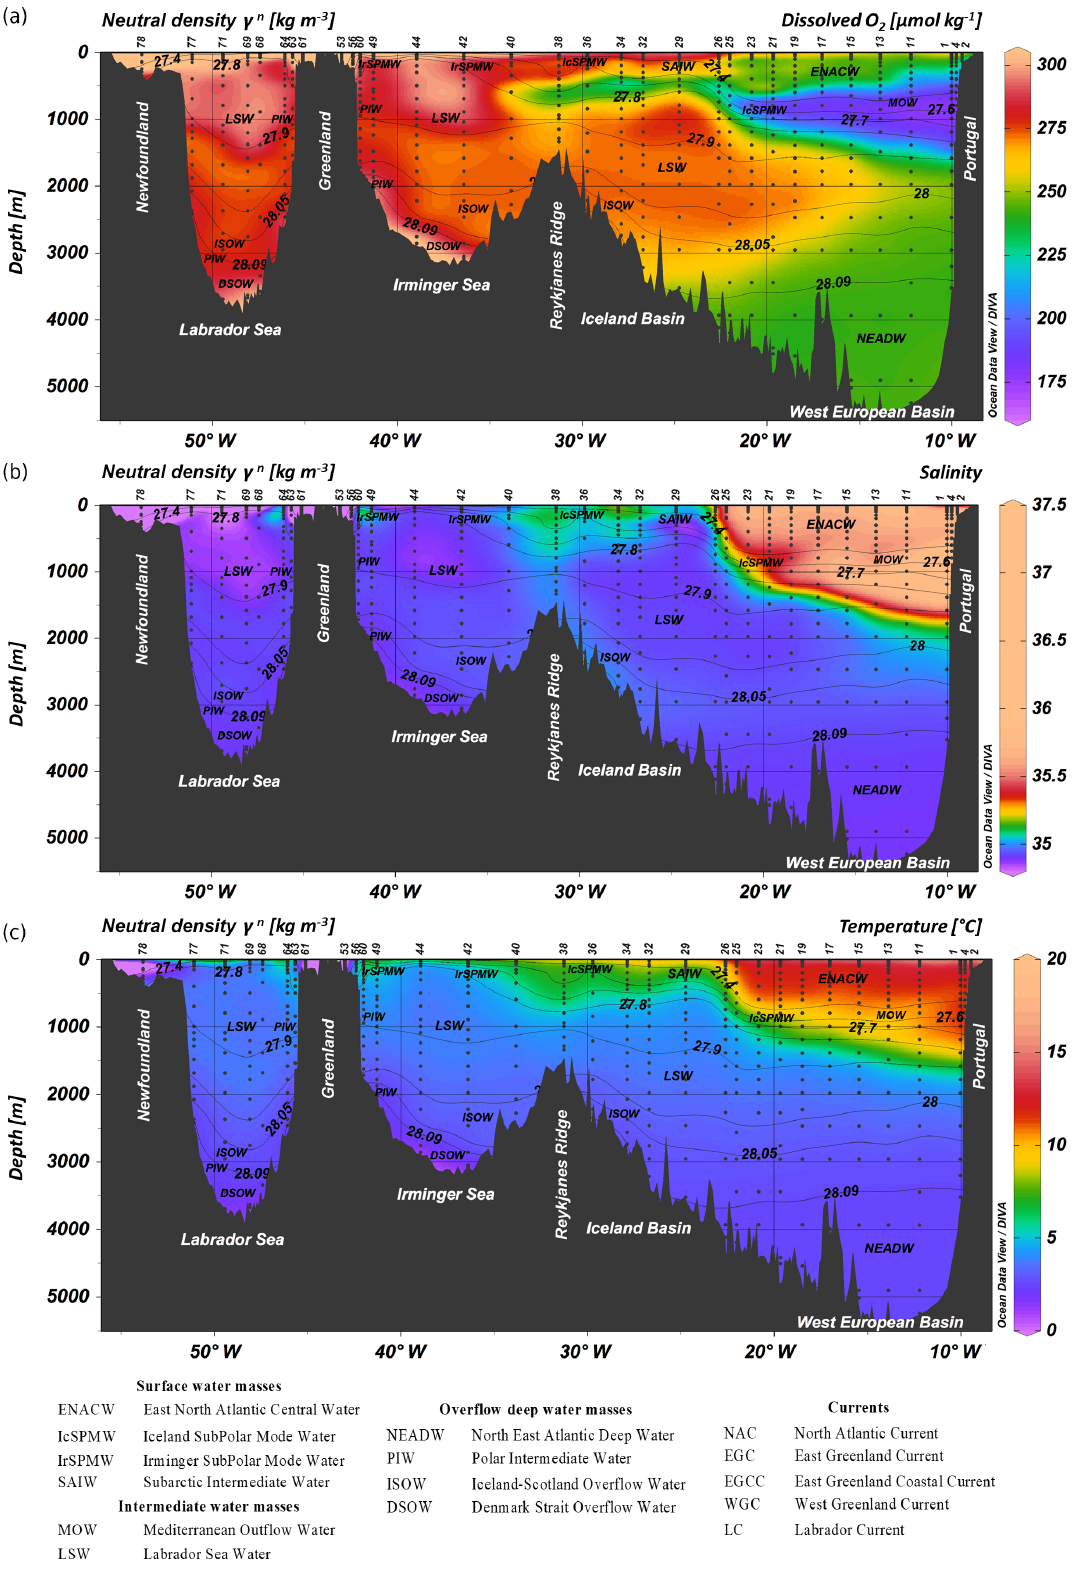
Figure 2. Parameters measured from the regular CTD cast represented as a function of depth for the GA01 section for (a) dissolved oxygen (O 2 , µmolkg − 1 ), (b) salinity, and (c) temperature ( ◦ C). The contour lines represent isopycnals (neutral density, γ n , in units of kilogram per cubic meter) (Ocean Data View (ODV) software, version 4.7.6, Schlitzer, 2016; http://odv.awi.de, last access: 30 January